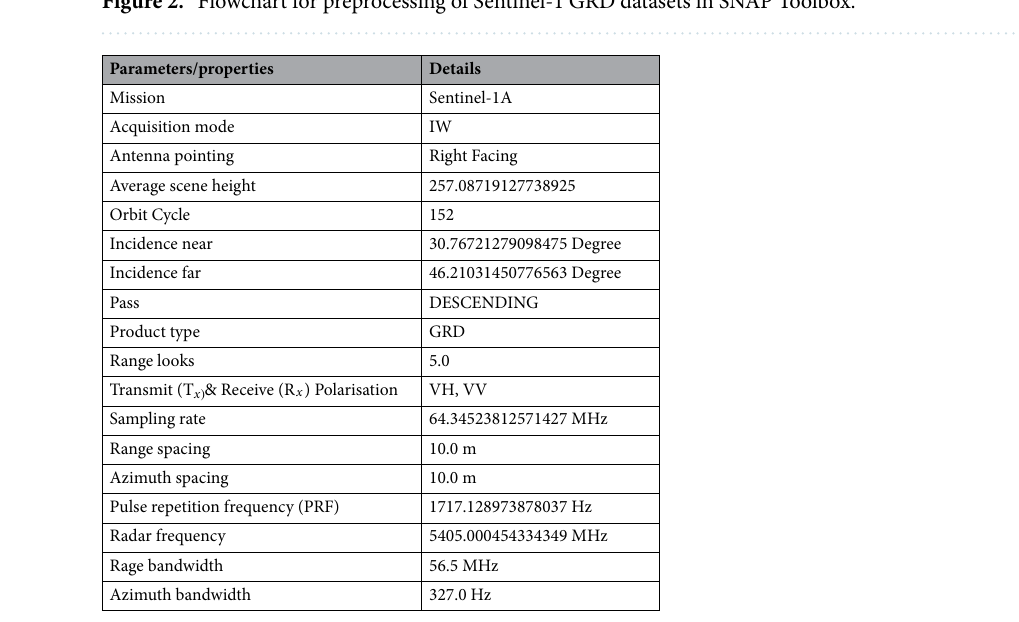
Figure 2. Flowchart for preprocessing of Sentinel-1 GRD datasets in SNAP Toolbox.